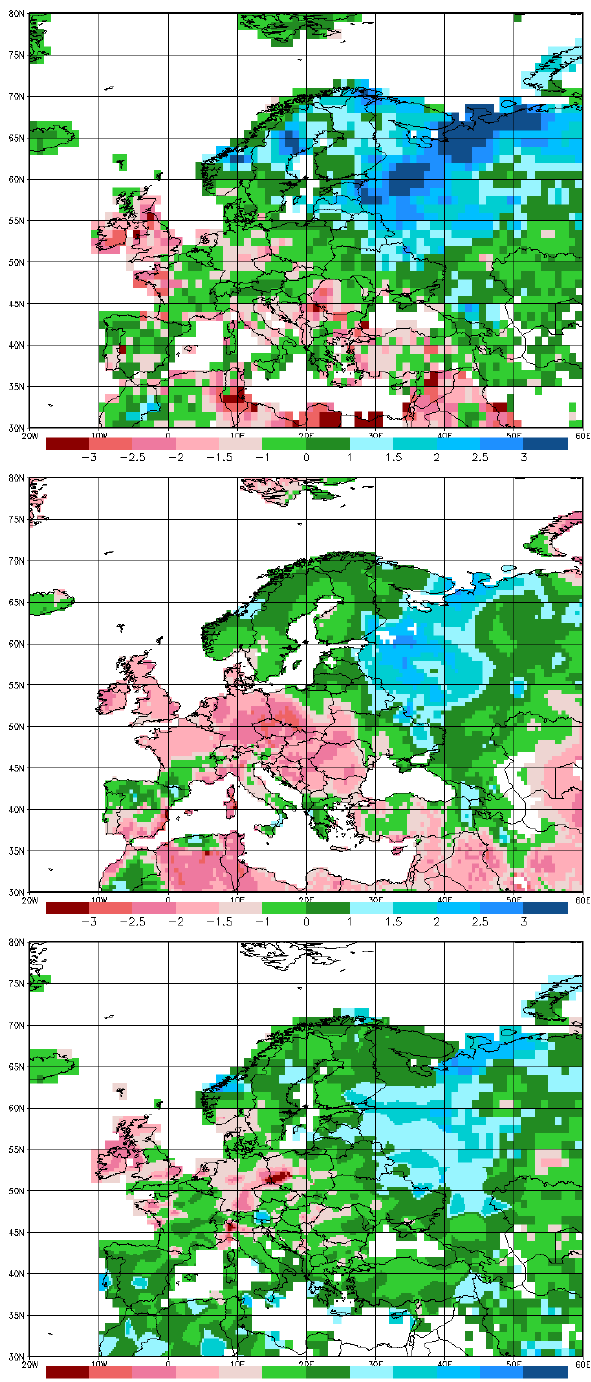
Figure 15. Comparison of the GPCC-DI (top), SPEI (middle) and SPI-EDO (bottom) with 1-month aggregating interval for Au- gust 2003. The color scale is the same as in Fig. 3.